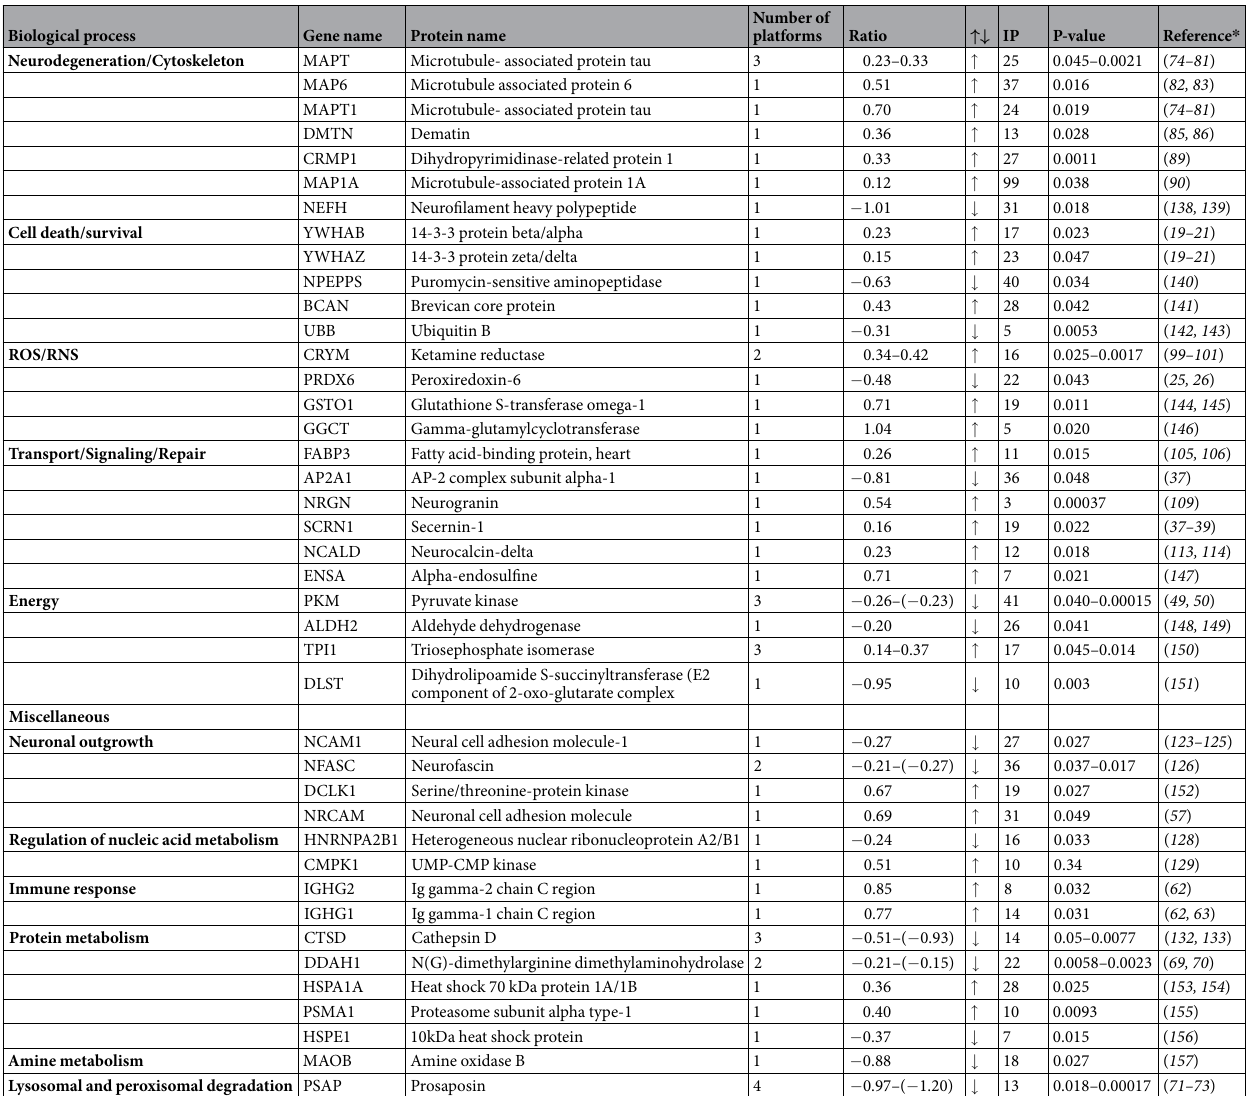
Table 5. Mass spectrometry analysis of brain tissue biopsies from structurally normal-appearing frontal cortex- STUDY B . Significantly up- or downregulated proteins in biopsies from patients with diffuse axonal injury (DAI) in comparison to idiopathic normal pressure hydrocephalus (iNPH). IP = Number of identified peptides, ↑↓ = Increased or decreased, * = Reference provided in supplementary